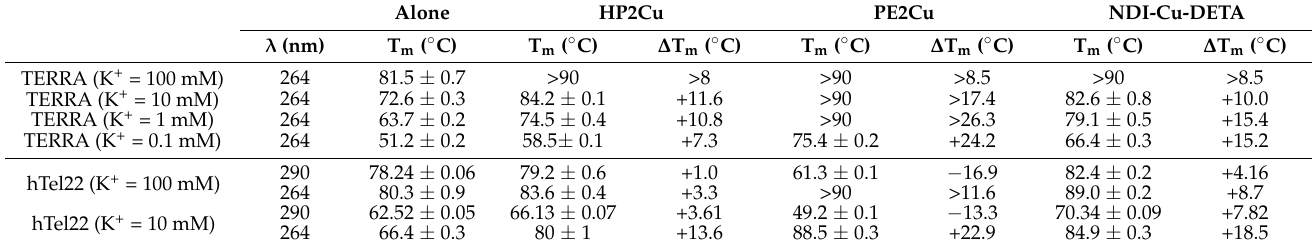
Table 1. CD analysis of HP2Cu and PE2Cu binding towards G4 sequences. ∆ T m values were measured by CD melting of 5 µ M oligonucleotides, in the presence of 10 µ M compounds, in 10 mM lithium cacodylate buffer (pH 7.4), at the indicated potassium